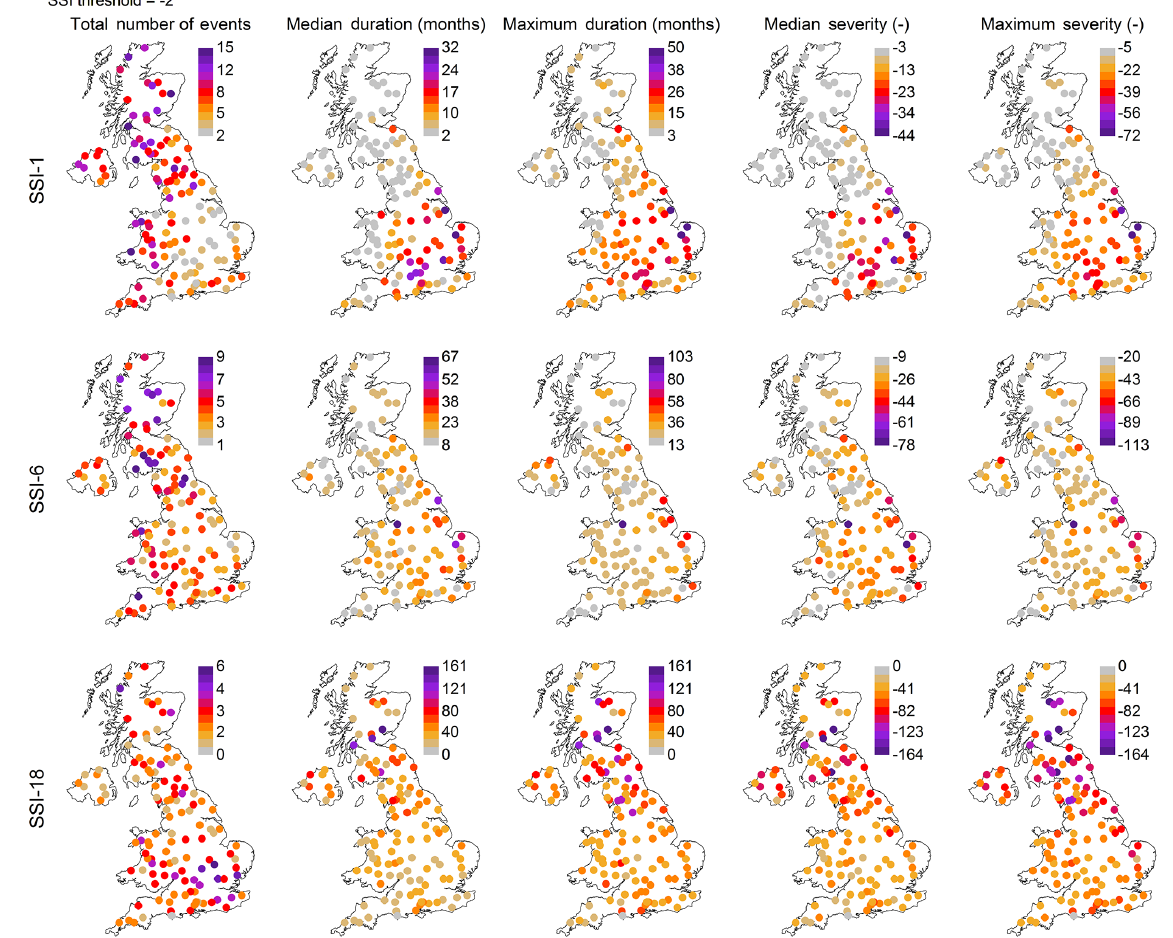
Figure 5. Maps showing selected hydrological drought characteristics based on SSI-1, SSI-6 and SSI-18 using a threshold of − 2. Note that the colour scale is different for each accumulation period to best show the spatial variability of the results. Table 3. Correlation coefficients for Spearman correlations between hydrological drought characteristics and SAAR ( ∗ α = 0.1; ∗∗ α = 0.01;